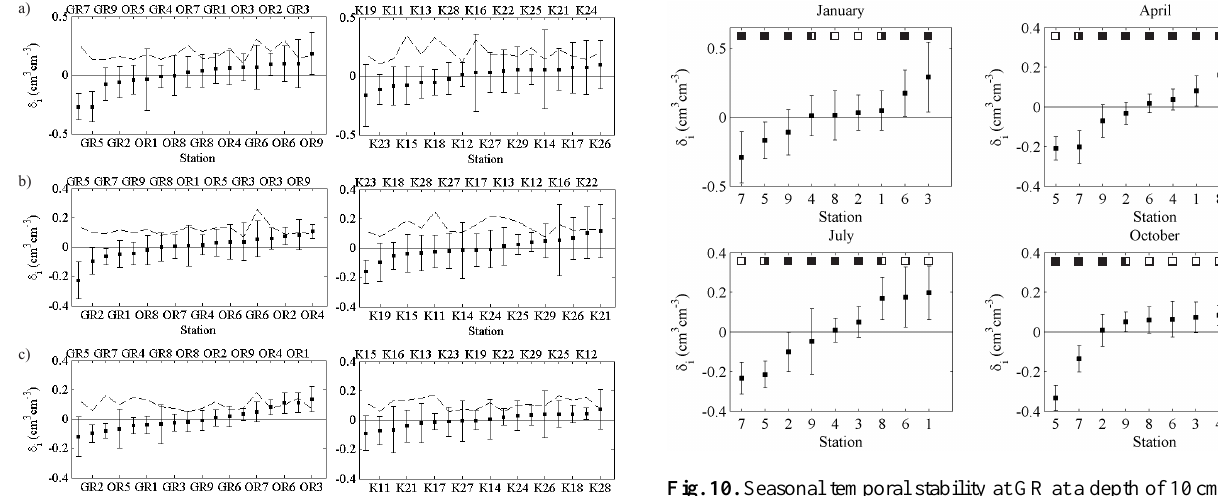
Fig. 10. Seasonal temporal stability at GR at a depth of 10cm. The boxes show the mean relative difference and the bars one standard deviation of the relative difference. The white half boxes at the top of the figure show where a station is similar ( α = 0 . 05) to its neigh- bour on the respective